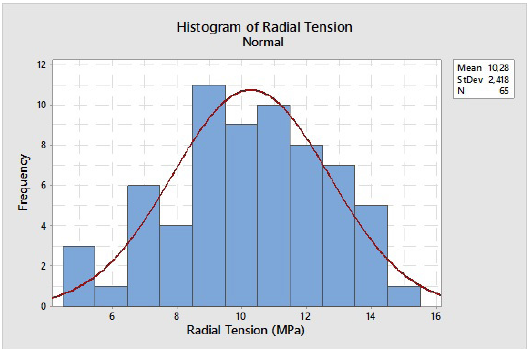
Figure 6. Histogram of Radial Tension Strength.